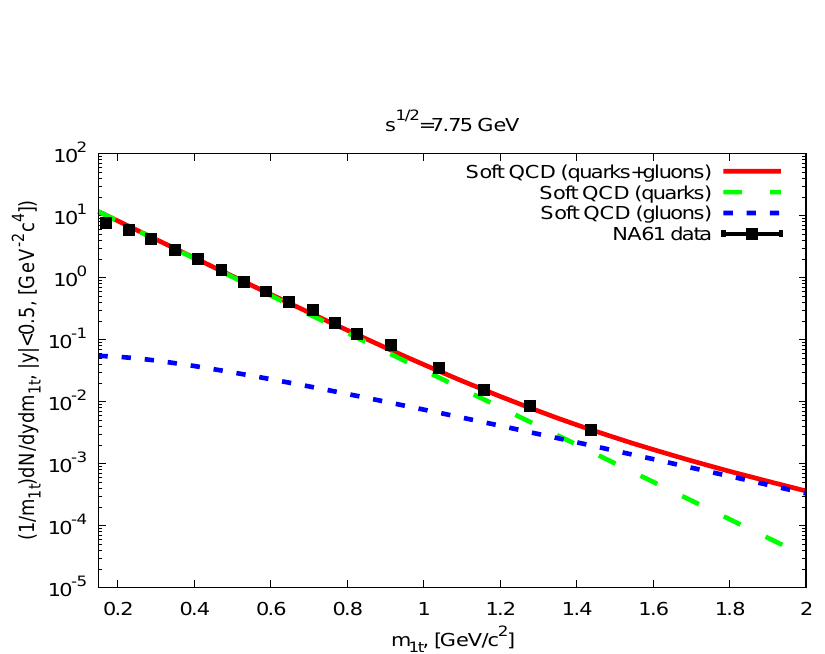
Figure 1. Results of the calculations of the inclusive cross section of pion production in pp collisions as a function of the transverse mass at s 1 / 2 = 7.75 GeV or at the initial momentum P in = 31 GeV / c in l.s.m. They are compared to the NA61 experimental data [12]